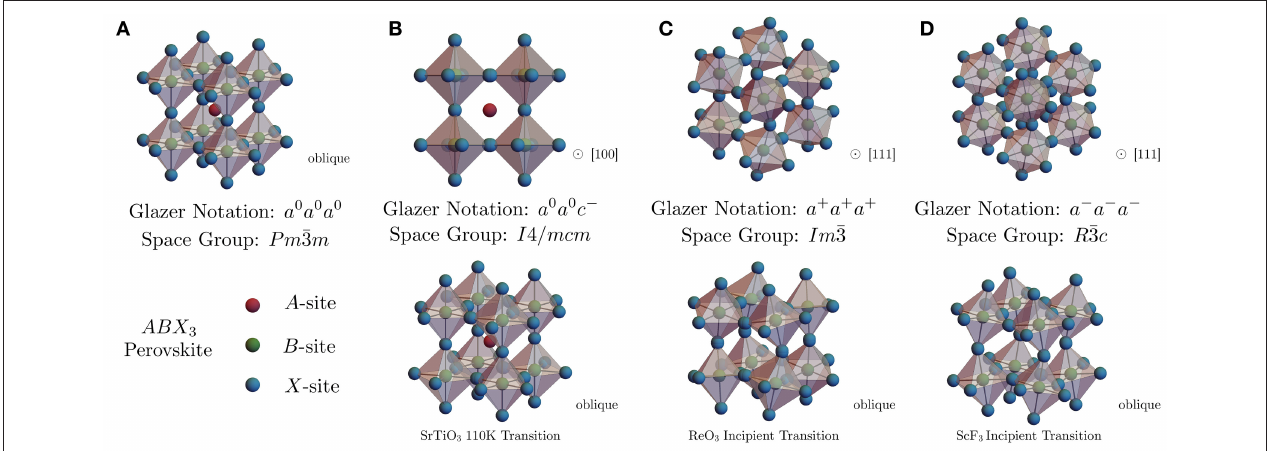
FIGURE 3 | Shown here is (A) the general perovskite structure of formula unit ABX 3 (see text), in the highest symmetry cubic space group Pm ¯ 3 m corresponding to a Glazer tilt notation a 0 a 0 a 0 . Also shown are common octahedral tilt lower-symmetry perovskites found in (B) the SrTiO 3 T c = 110K Pm ¯ 3 m to I 4 / mcm tetragonal structural transition (C) the triply degenerate M + 3 phonon condensation in the low- T , high- P ReO 3 structural transition (see text) and (D) the triply degenerate R + 4 phonon condensation responsible for the rhombohedral transition is B F 3 open perovskite 3 d -transition metal trifluorides which also acts as the dynamic soft-mode rotations in ScF 3 , corresponding to Glazer tilts of a 0 a 0 c − , a + a + a + , and a − a − a − ,